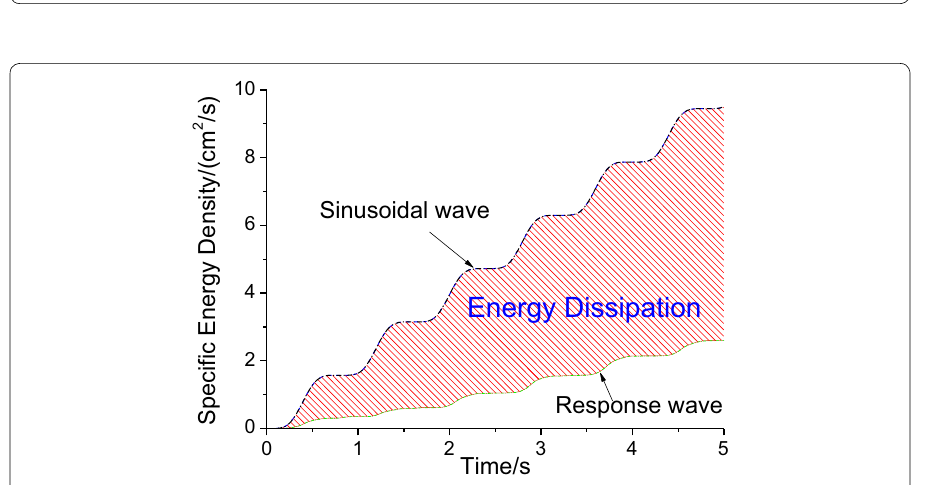
Fig. 6 Fourier amplitude spectra